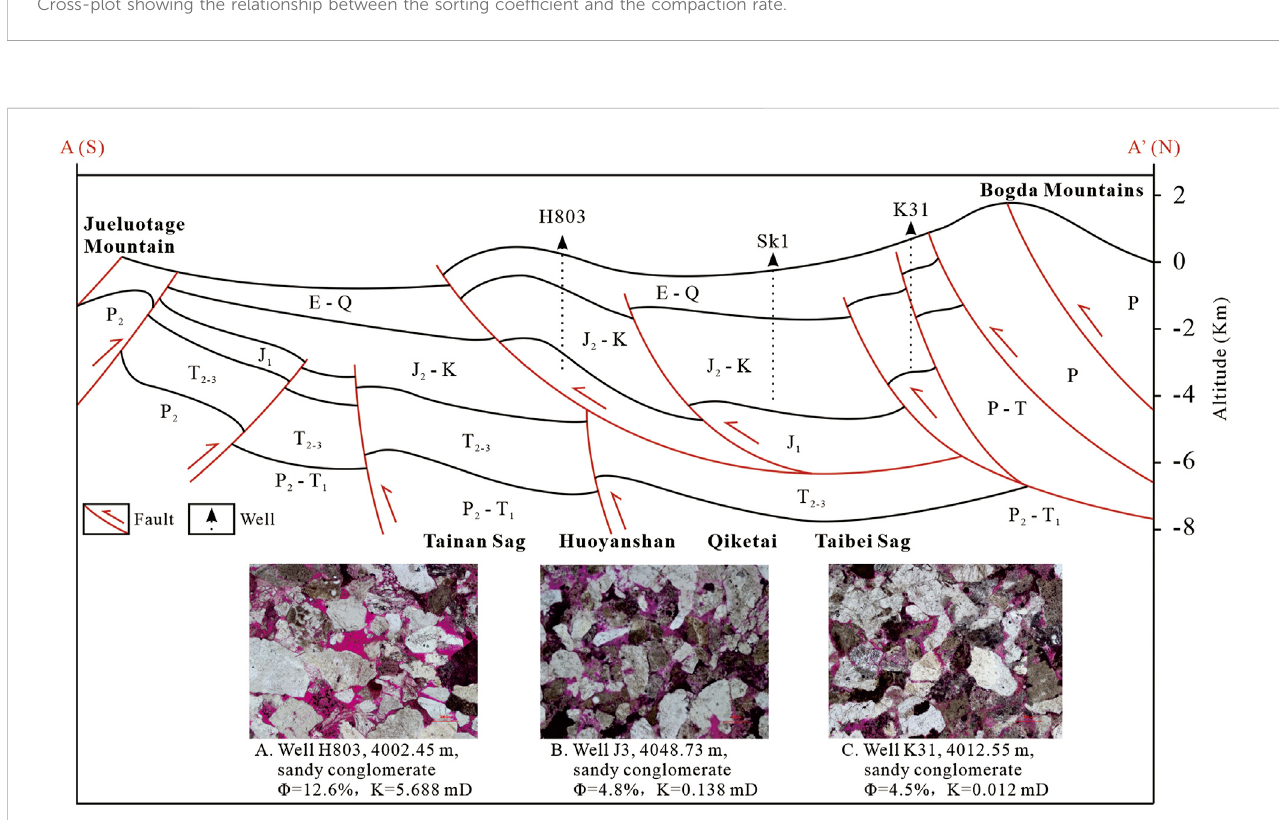
FIGURE 8 Simpli fi edpro fi lesketch showingthenappetectonics anditsin fl uenceoncompaction(modi fi edfromWuandZhao, 1997;Shou etal.,2005).The pro fi le location is shown in Figure